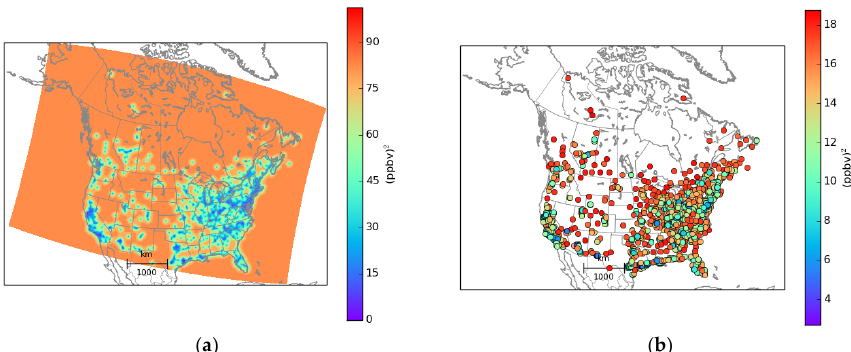
Figure 4. Analysis error variance for ozone optimal analysis case O 3 iter 1 . ( a ) is the analysis error on the model grid and ( b ) at the active observation sites. Note that the color bar of the left and right panels are different. The maximum of the color bar for the left panel correspond to σ 2 o + σ 2